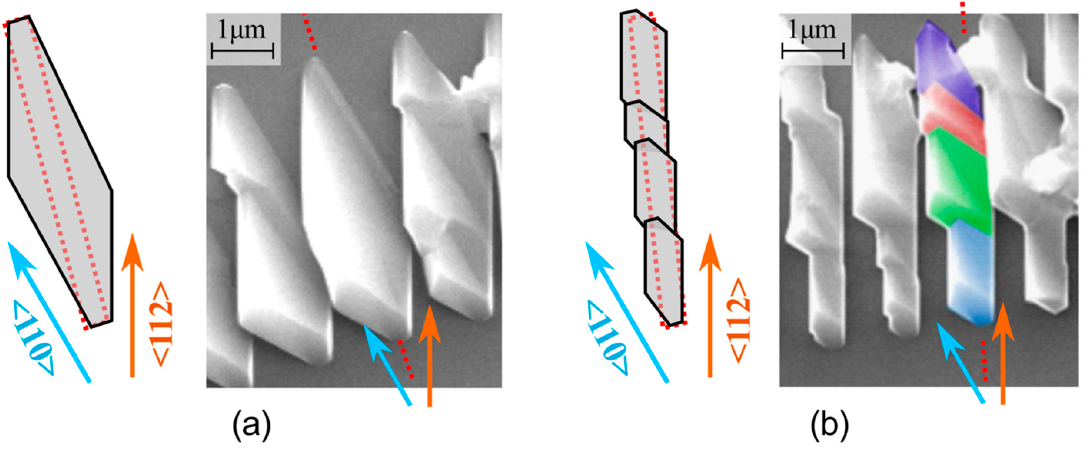
Figure 4. Schematics and SEM images illustrating the growth modality for intermediate orientations in between <112> and <110> directions. ( a ) multifaceted morphology with both {110} and {113} facets; ( b ) fragmented morphology resulting from the formation of multiple units. Each portion tends to overgrow above the oxide mask to re-align along <112> or <110> directions.